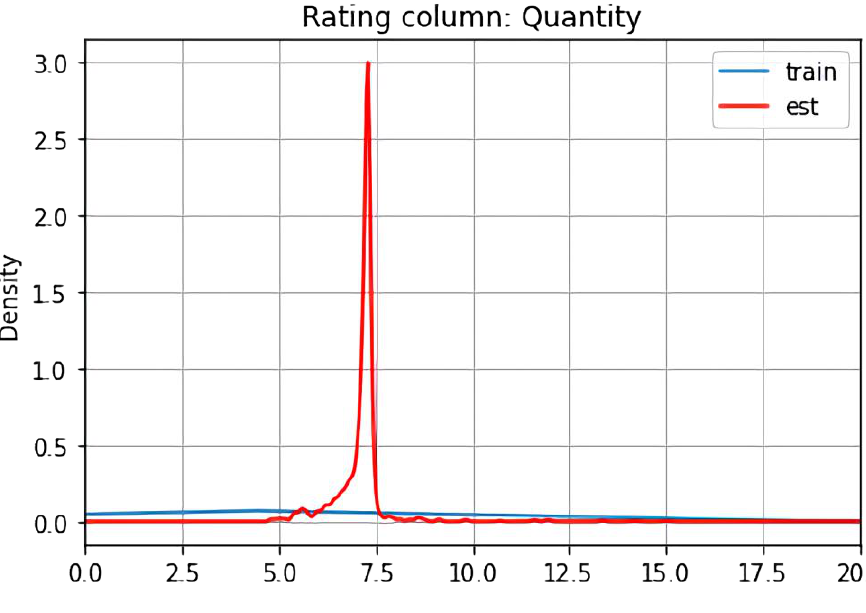
Figure 7. Estimated and train set